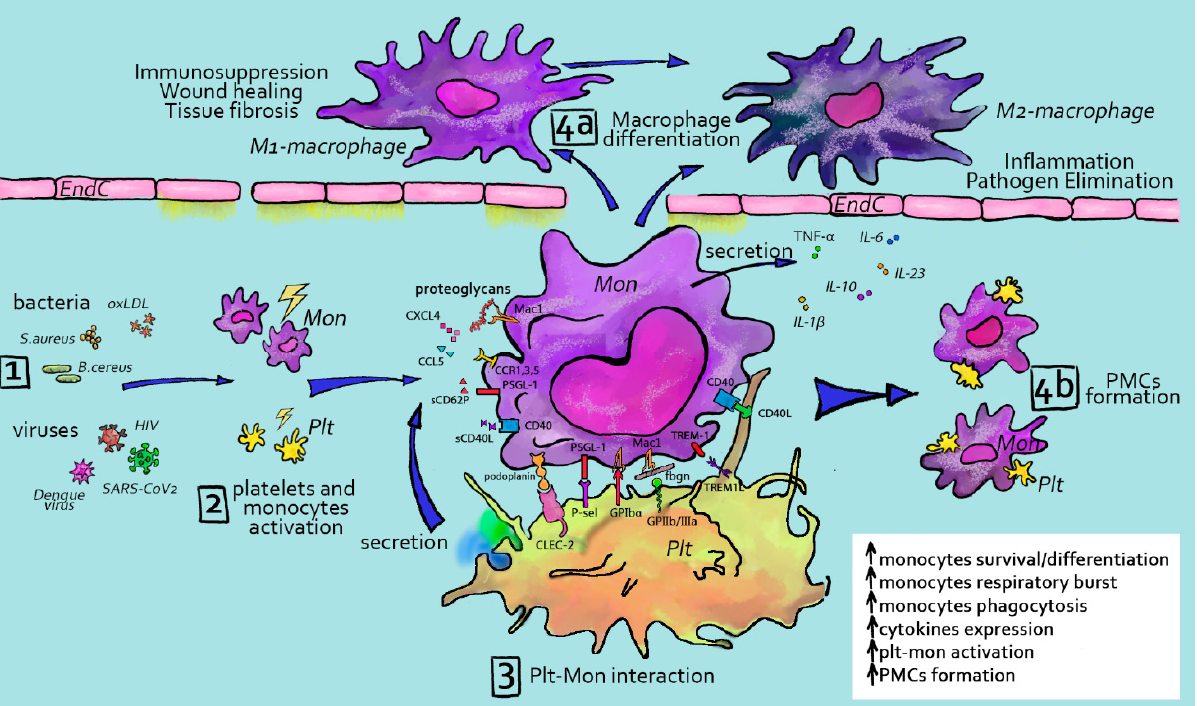
Figure 2. Platelet–monocyte interactions and platelet–monocyte complex (PMC) formation. Several factors such as bacterial or viral infection ( 1 ) can contribute to the activation of both platelets and monocytes ( 2 ). Once activated, platelets and monocytes can interact directly through receptors expressed on their surface, and soluble factors released from platelets can further modulate monocyte activity ( 3 ). This interaction can lead monocytes to extravasate and differentiate towards macrophages ( 4a ) or alternatively lead to platelet–monocyte complex formation ( 4b ). Cell activation is shown by yellow lightnings. Plt—platelet, Mon—monocyte, PMC—platelet–monocyte